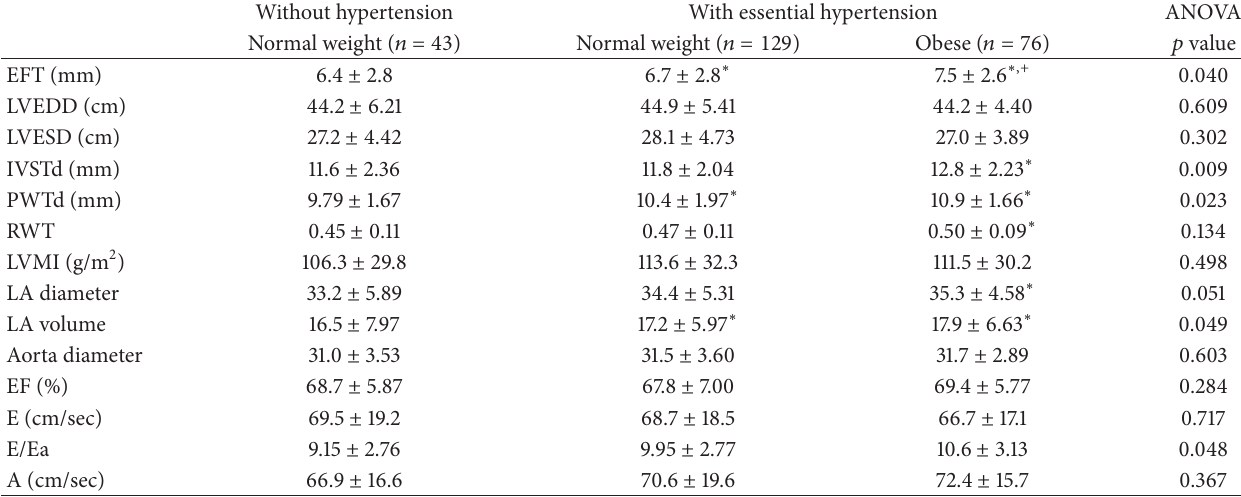
Table 4: The echocardiographic measurements of the study population in females.